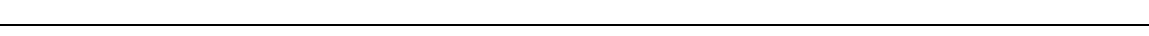
sections were blocked with 2% BSA prior to incubation with primary antibodies (listed in Supplementary Table 2). HUVEC for immuno fl uorescence and proximity ligation assay (PLA) were grown on gelatinised coverslips in 12-well plates. Cells were fi xed with 4% paraformaldehyde for 15 min prior to blocking with 3% BSA for 1h. PLA was performed by manufacturer ’ s instructions (Duolink Sigma). Primary antibodies listed in Supplementary Table 2. All tissue sections and HUVEC were mounted with Prolong Diamond (Molecular Probes) and allowed to dry overnight before imaging. Confocal microscopy was carried out on a Carl Zeiss LSM780. Images were analysed with ImageJ (NIH) and Volocity software (PerkinElmer).